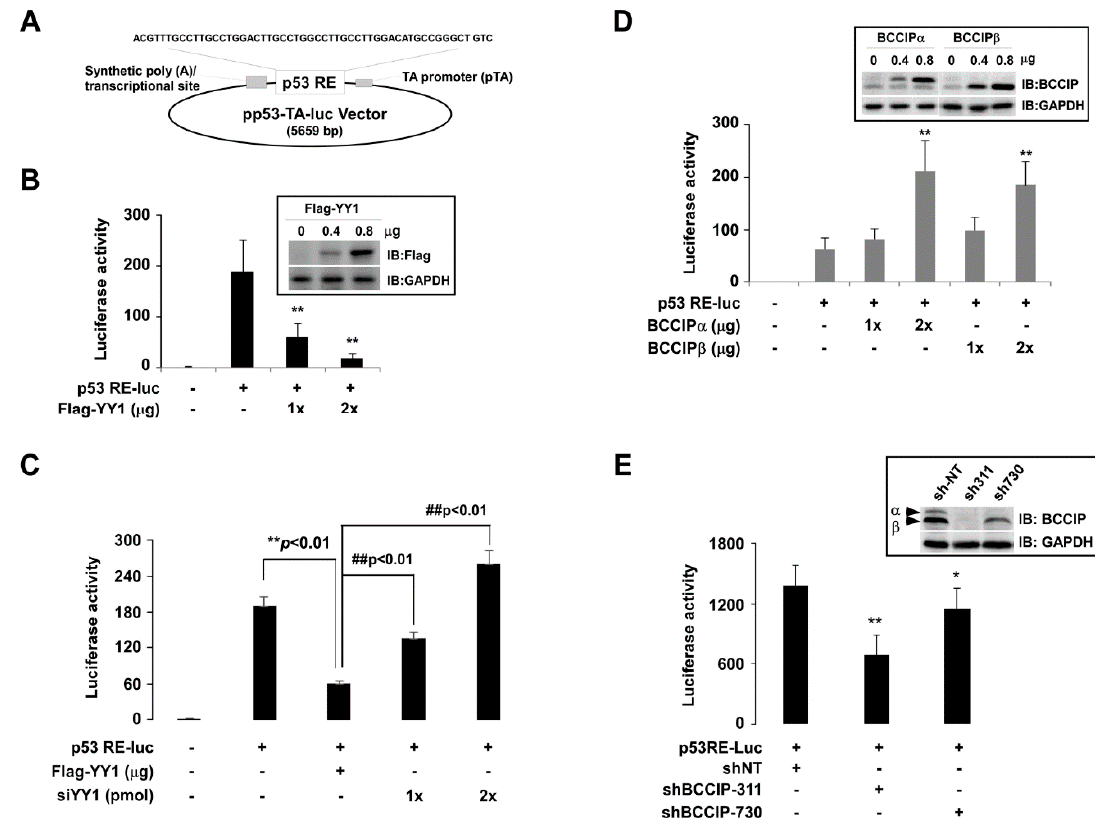
Figure 4. P53RE-mediated luciferase activity was regulated by YY1 and BCCIP in HCT116 (p53 +/+ ) cells. ( A ) Schematic diagram of p53RE-Luc plasmid. Multiple response elements of p53 were inserted into a pp53-TA-Luc vector. ( B , C ) E ff ects of YY1 on p53RE-Luc luciferase activity. P53RE-Luc dual luciferase activity was measured after co-transfection with p53RE-Luc and Flag-YY1 or siYY1 (48 h) ( n = 3). ** p < 0.01, t -test, comparison to p53RE-Luc-transfected group, while ## p < 0.01, t -test, comparison to Flag-YY1-transfected group. ( D , E ) E ff ects of BCCIP α / β on p53RE-Luc luciferase activity. P53RE-Luc dual luciferase activity was measured after co-transfection of p53RE-Luc and BCCIP α / β or shBCCIP (48 h) ( n = 3). ** p < 0.01, t -test, comparison to p53RE-Luc-transfected group. shBCCIP-311 and shBCCIP-730 target di ff erent